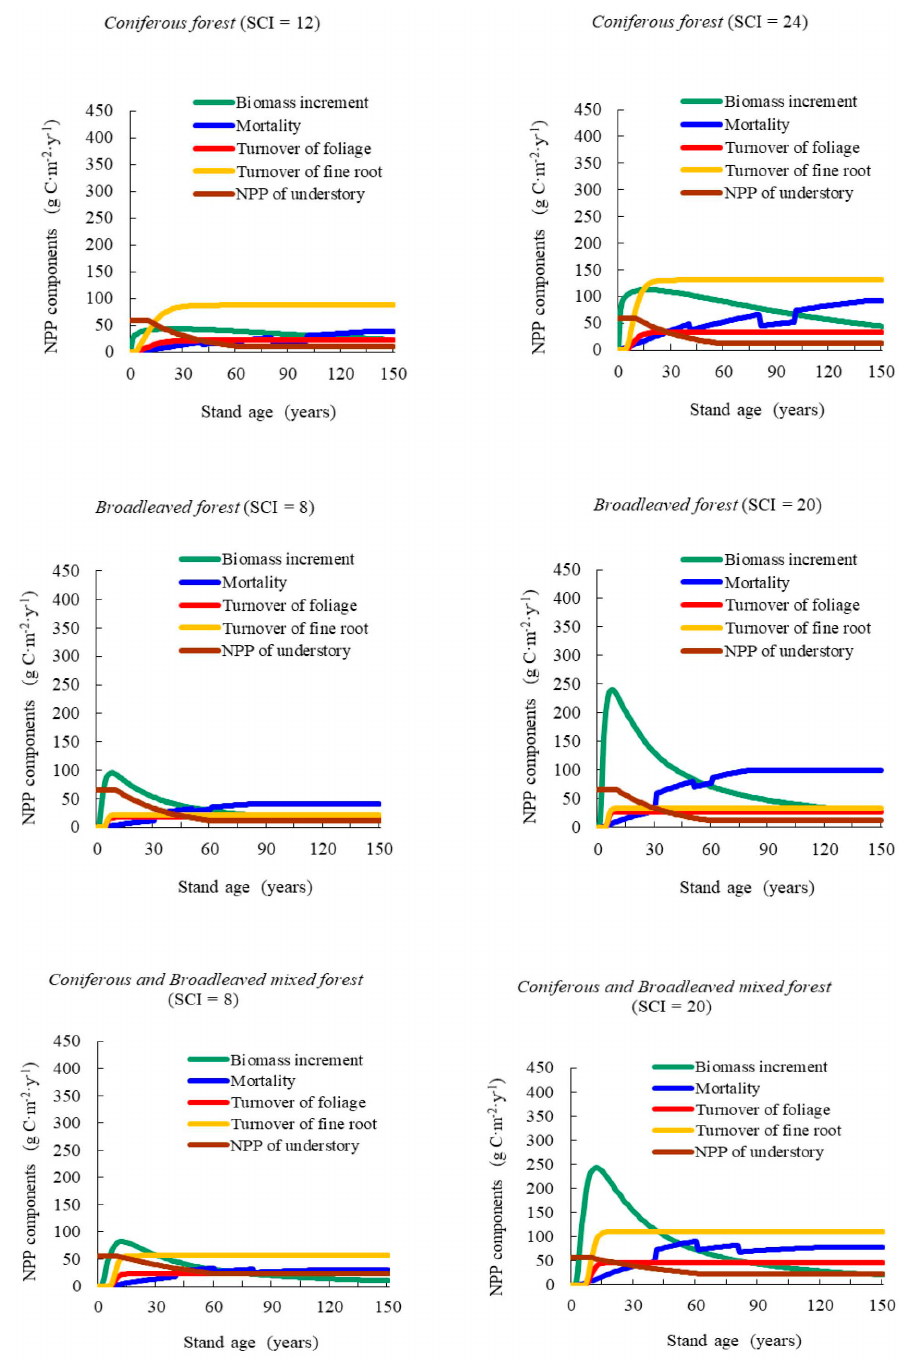
Figure 5. Variations of NPP components with age at minimum and maximum SCI for three forest type type groups.